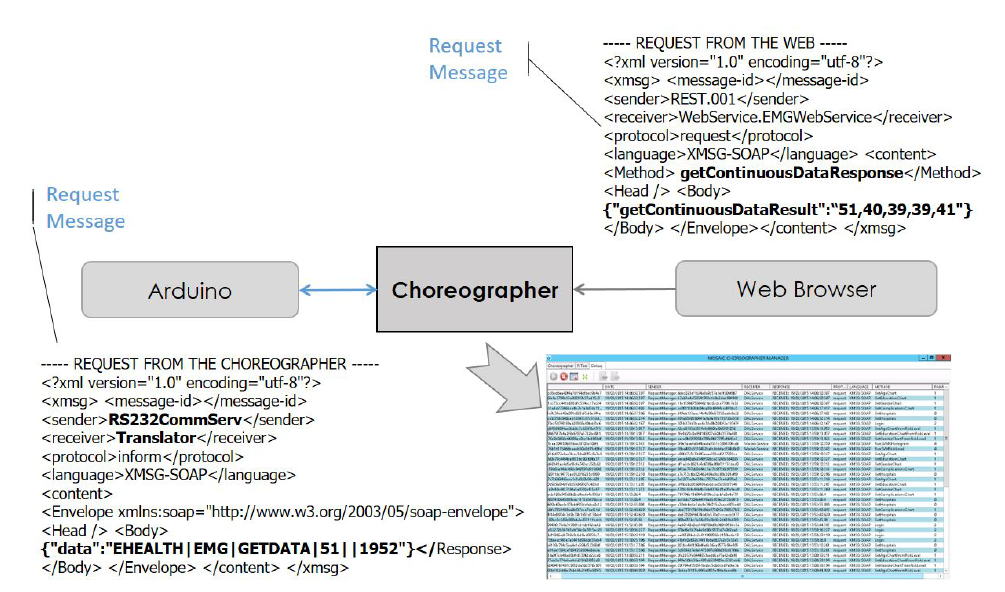
Figure 6. Choreographer track